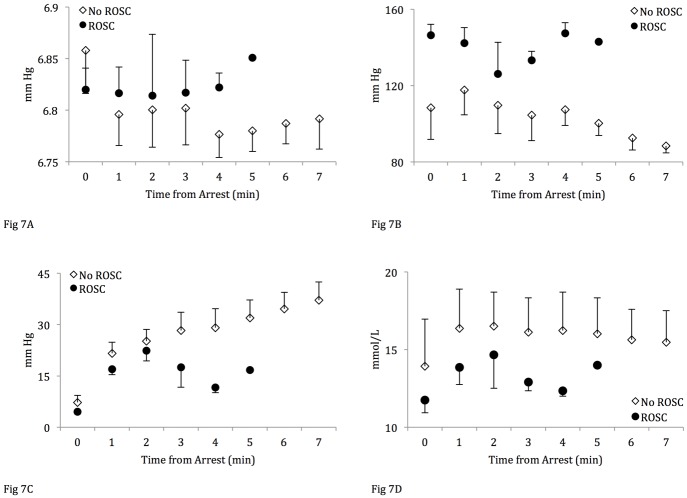
Comparison of arterial blood gas analysis between groups during resuscitation.(A) PaO2, (B) PaCO2, (C) pH, (D) Lactate. Gas sample “0” depicts “arrest gas.” Data are mean ± SEM bars. The number of lambs in the ROSC group drops with each successful ROSC (at “0” n = 18, at “1” n = 17, at “2” n = 8, at “3” n = 4, at “4” n = 2, at “6” n = 1).